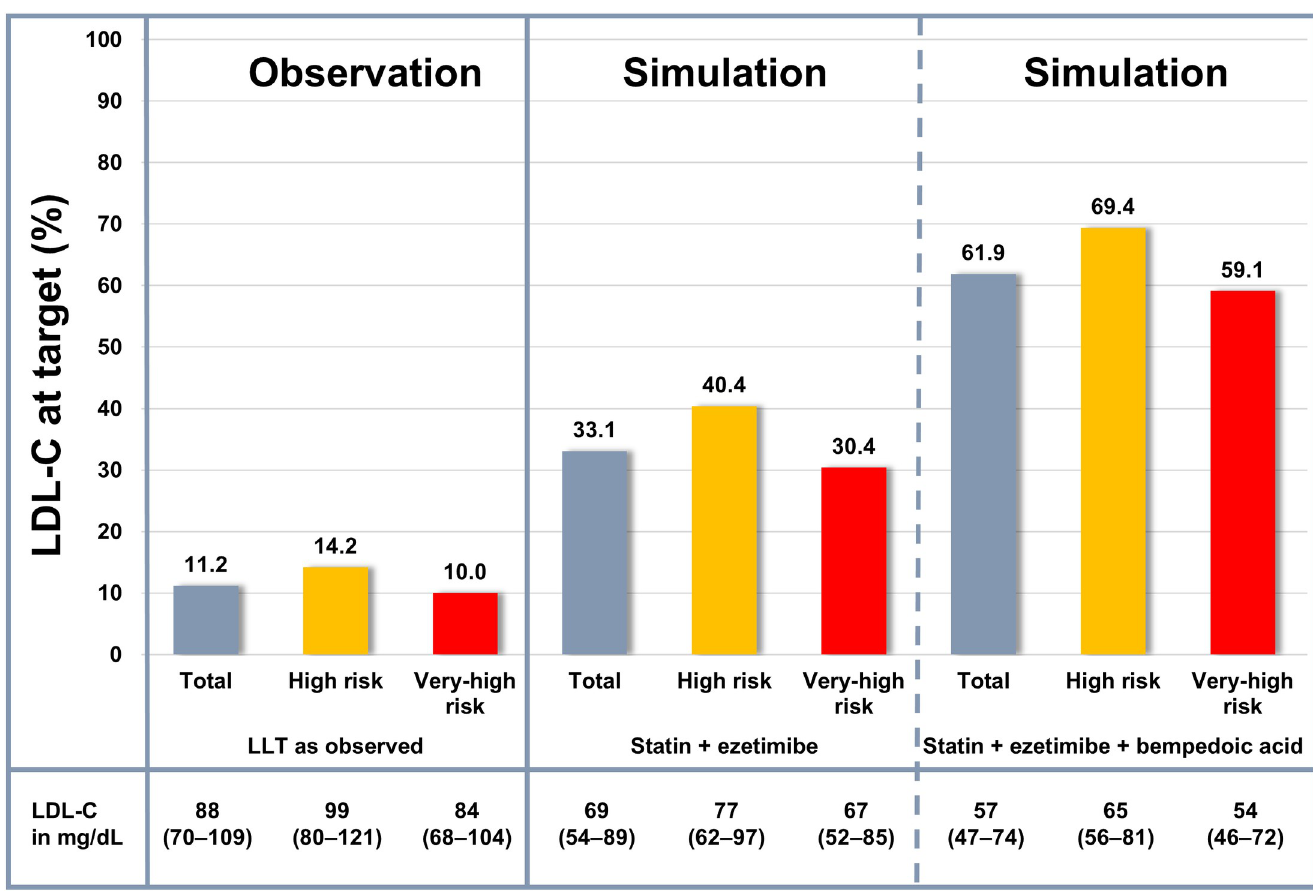
Fig 3. LDL-C target attainment in the total cohort and stratified by risk as observed and simulated. LDL-C concentrations are given as median (interquartile range). LDL-C: Low-density lipoprotein cholesterol. LLT: Lipid-lowering